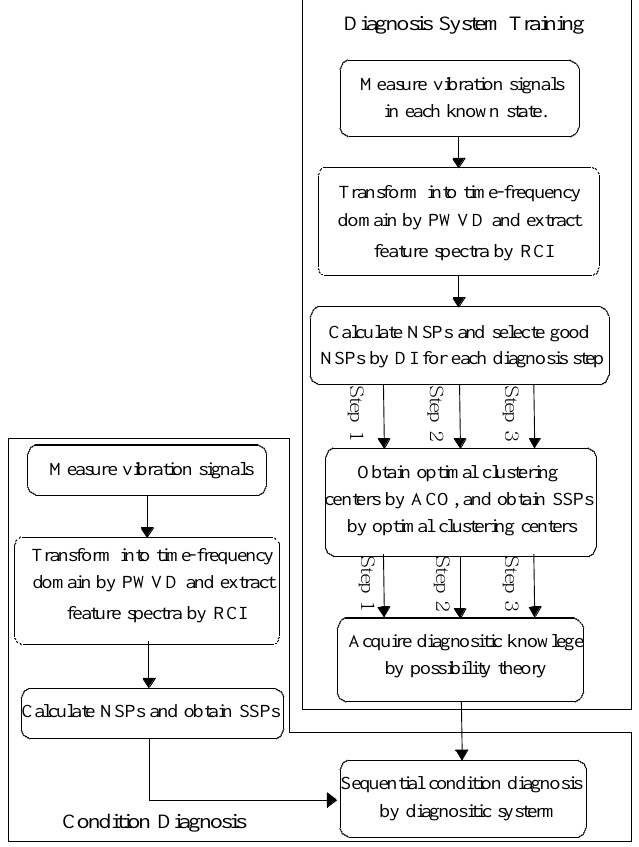
Figure 8. Flowchart for condition